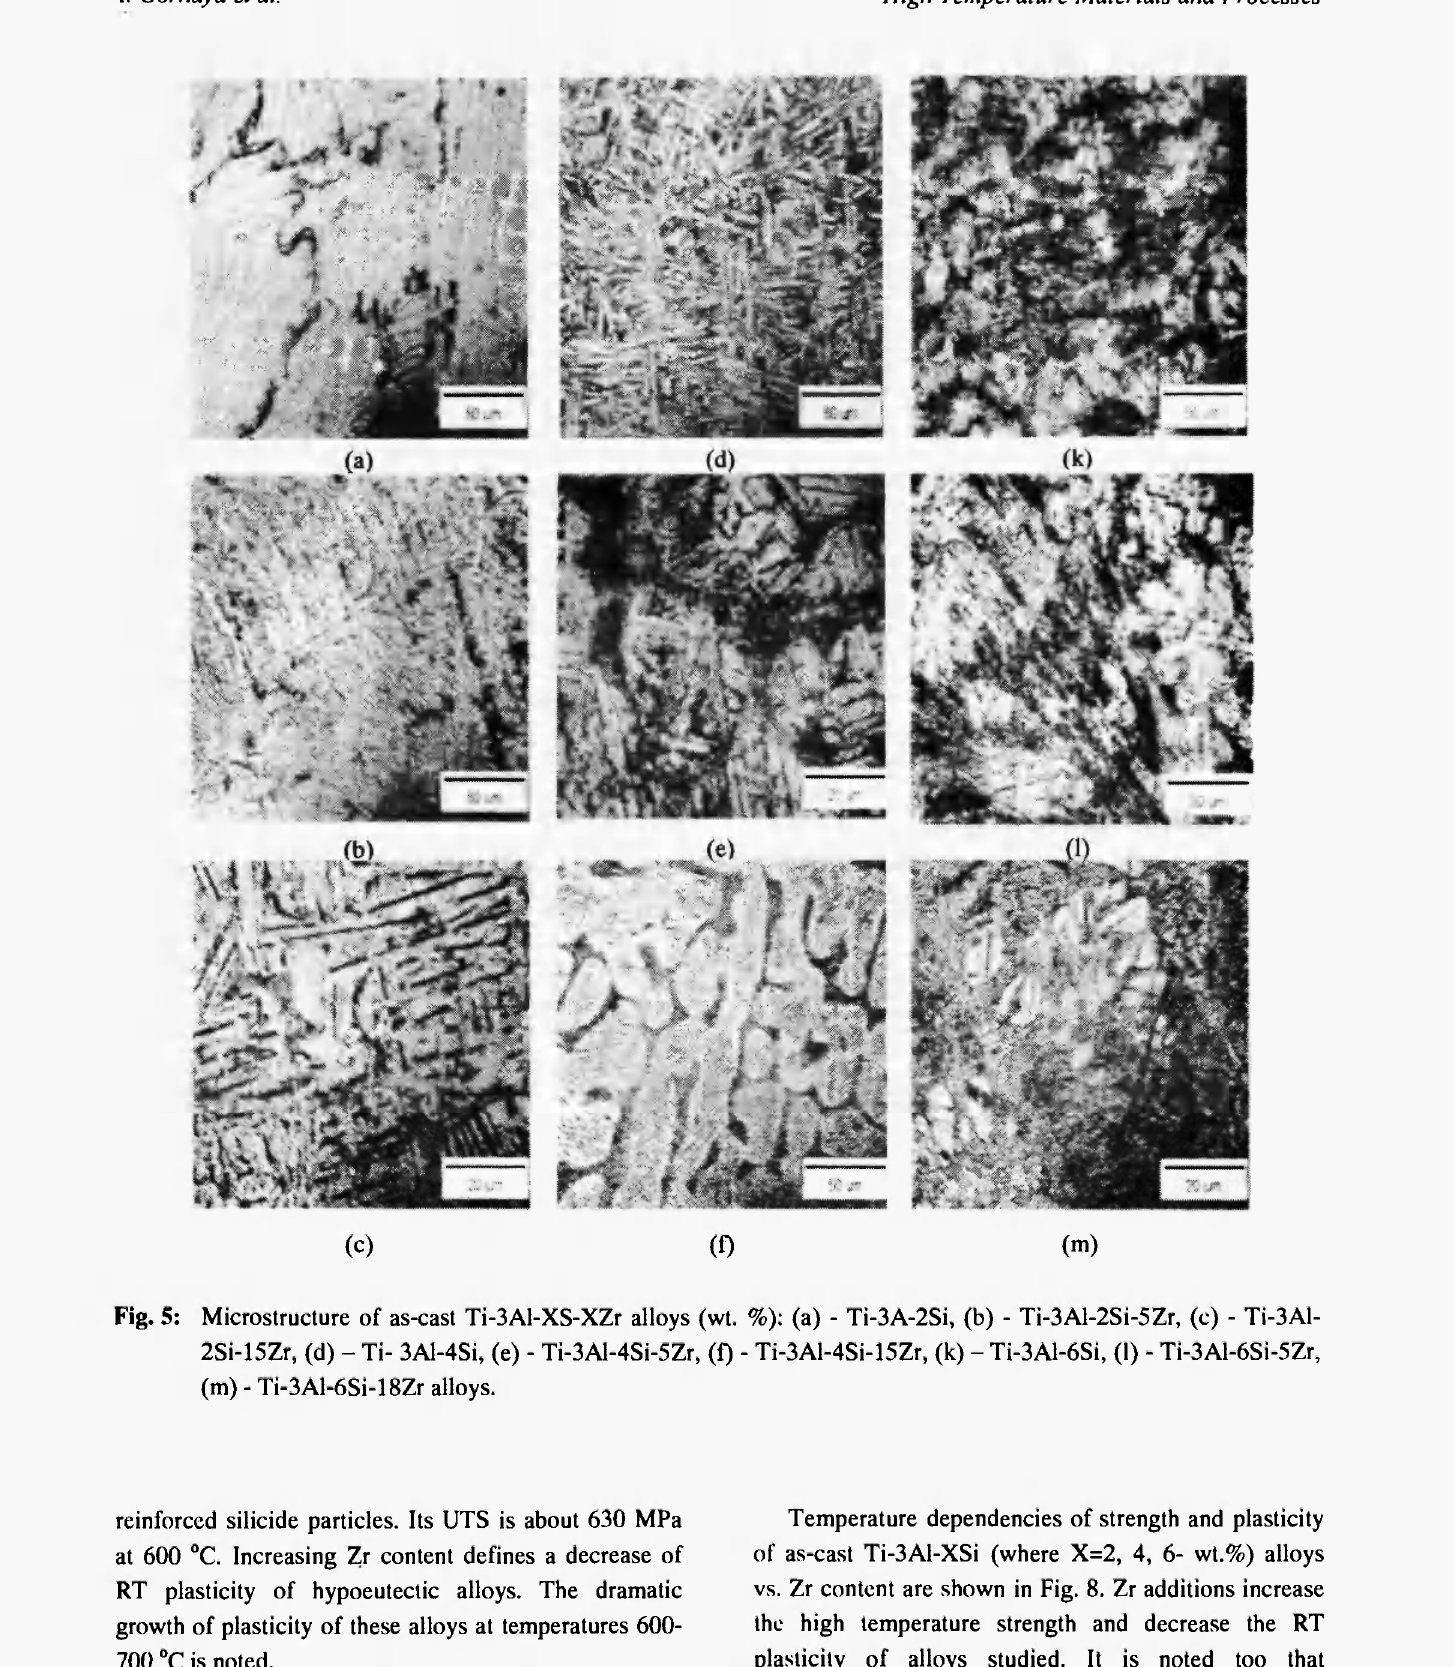
reinforced silicide particles. Its UTS is about 630 MPa at 600 °C. Increasing Zr content defines a decrease of RT plasticity of hypoeutectic alloys. The dramatic growth of plasticity of these alloys at temperatures 600- 700 °C is noted.